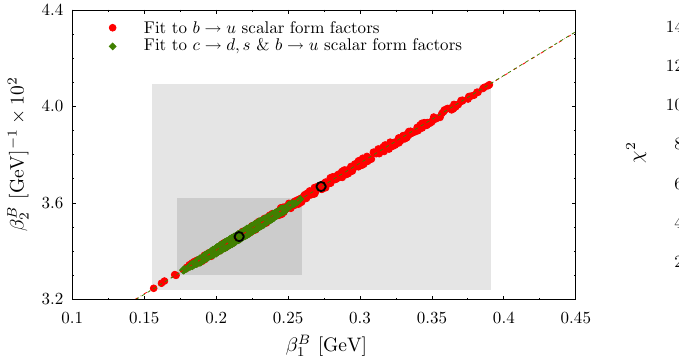
Fit to b → u scalar form factors Fit to c → d,s & b → u scalar form factors